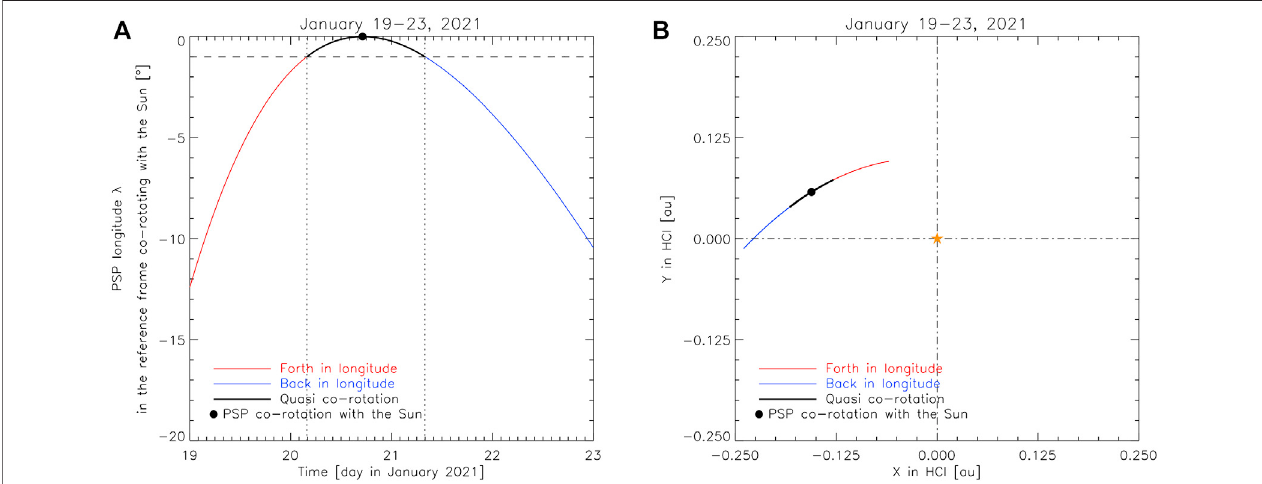
FIGURE 1 | PSP longitude λ in the reference frame co-rotating with the Sun (A) and PSP trajectory around the Sun (yellow star) on the HCI equatorial plane (B) , during PSP encounter 7 with the Sun, from January 19 − 23, 2021. Periods when PSP moves back and forth relative to the Sun or is in quasi co-rotation are indicated in blue, red, and thick black, respectively; the full dot marks the instant when PSP is co-rotating with the Sun. The horizontal dashed line at 1 ° in (A) displays the longitude tolerance applied to identify the PSP — Sun quasi co-rotation period (delimited by vertical dotted